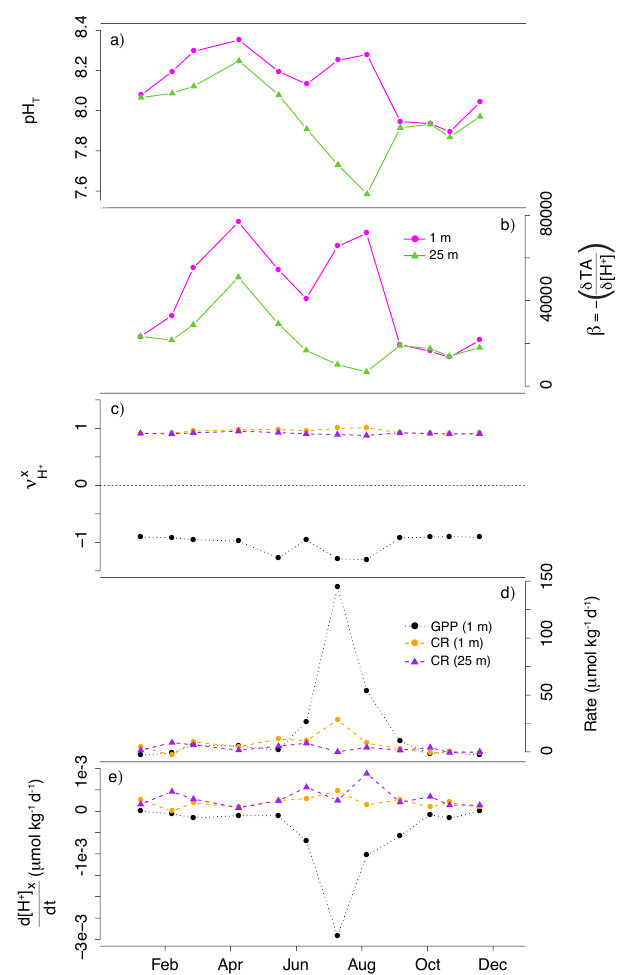
Figure 7. (a) pH T (at in situ temperature) and (b) acid–base buffer- ing capacity β at 1 and 25m depth; (c) stoichiometric coefficient for the proton ν x ,d) process rate (µmolkg − 1 d − 1 ) and (e) d [ H H + (µmolkg − 1 d − 1 ) for gross primary production (GPP; at 1m depth) and community respiration (CR; at 1 and 25m depth) at Den Osse in